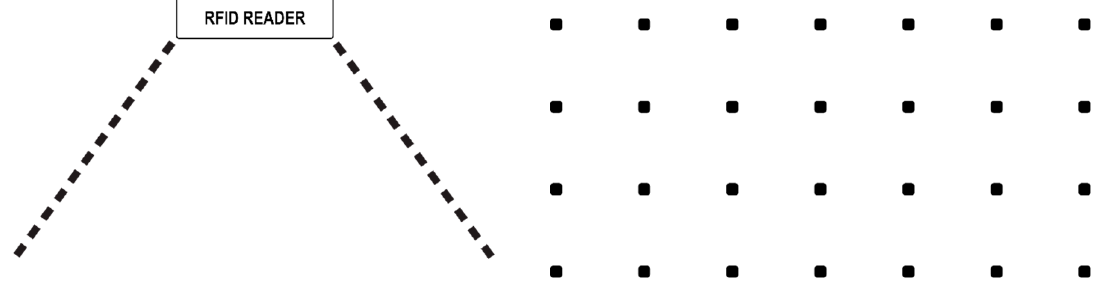
Figure 7. The mounted RFID reader ( left ) and the LANDMARC tags ( right ). Table 2. Impinj xArray antenna